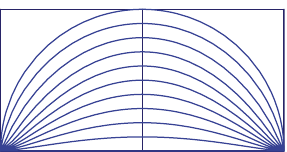
Figure 11: Modified circular paths with the optimized parameters β = 1 . 45 and γ = 12 .